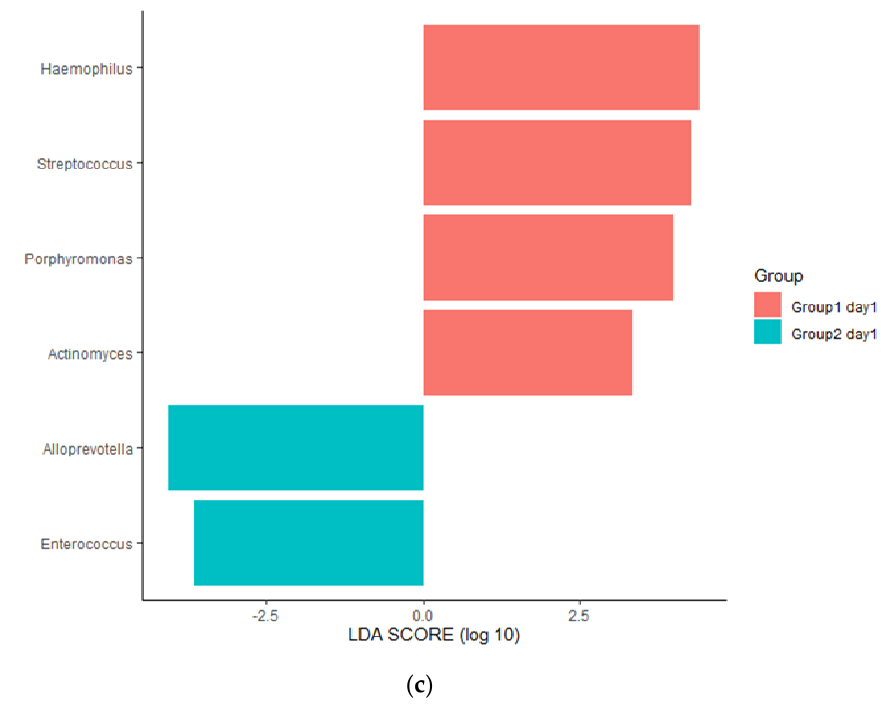
Figure 2. The respiratory microbiome of intubated patients with pneumonia differed between the failed extubation (Group1) and successful extubation groups (Group2). ( a ) Shannon diversity index and Simpson index. ( b ) Bray–Curtis distance of the respiratory microbiota, shown as a PCoA two-dimensional map. Each dot represents one sample. ( c ) Histogram of unique biomarker bacteria detected based on the LDA effect size (>2.5-fold).